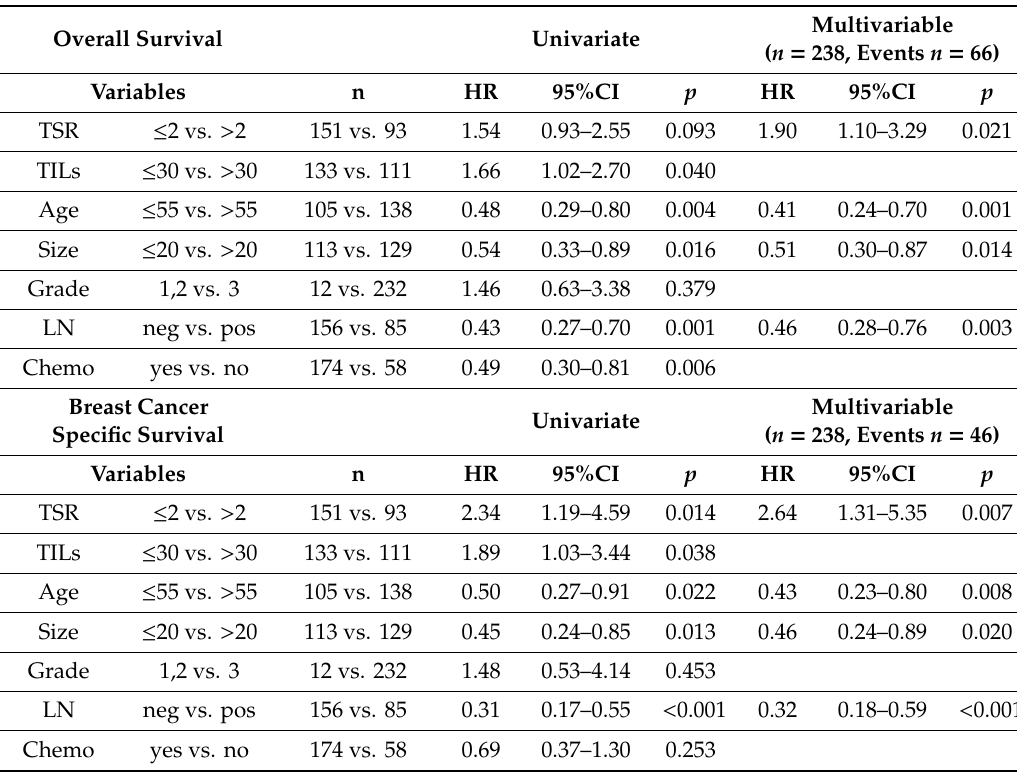
Table 1. Univariate and multivariate analysis for overall survival (OS) and breast cancer specific survival (BCSS) in triple negative breast cancer (TNBC). Abbreviations: n, sample number; HR, hazard ratio; CI, confidence interval; p , probability